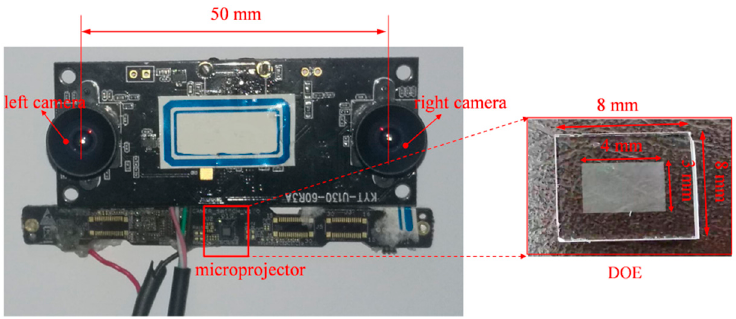
Figure 9. Experimental setup.